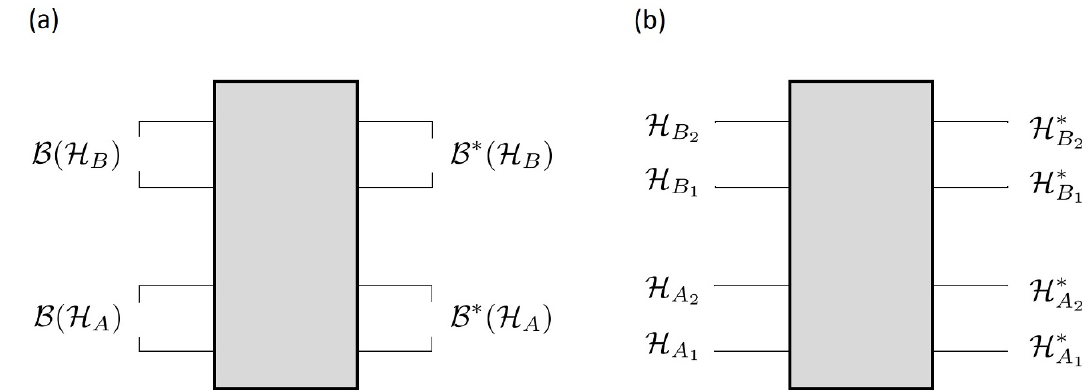
Figure 22 . (a) A diagrammatic representation of the R tensor, as per eq. (6.3). (b) An equiv- alent diagrammatic representation of the R tensor, where tensor legs have been relabelled by the isomorphism of Hilbert spaces as per eq.